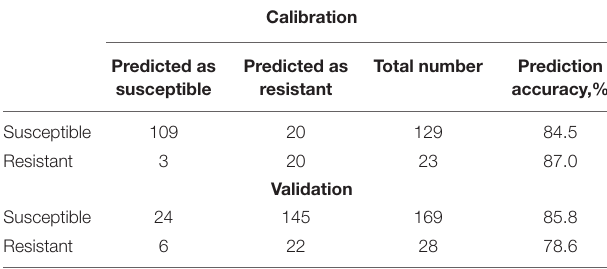
TABLE 8 | 60:40 prediction and validation model.